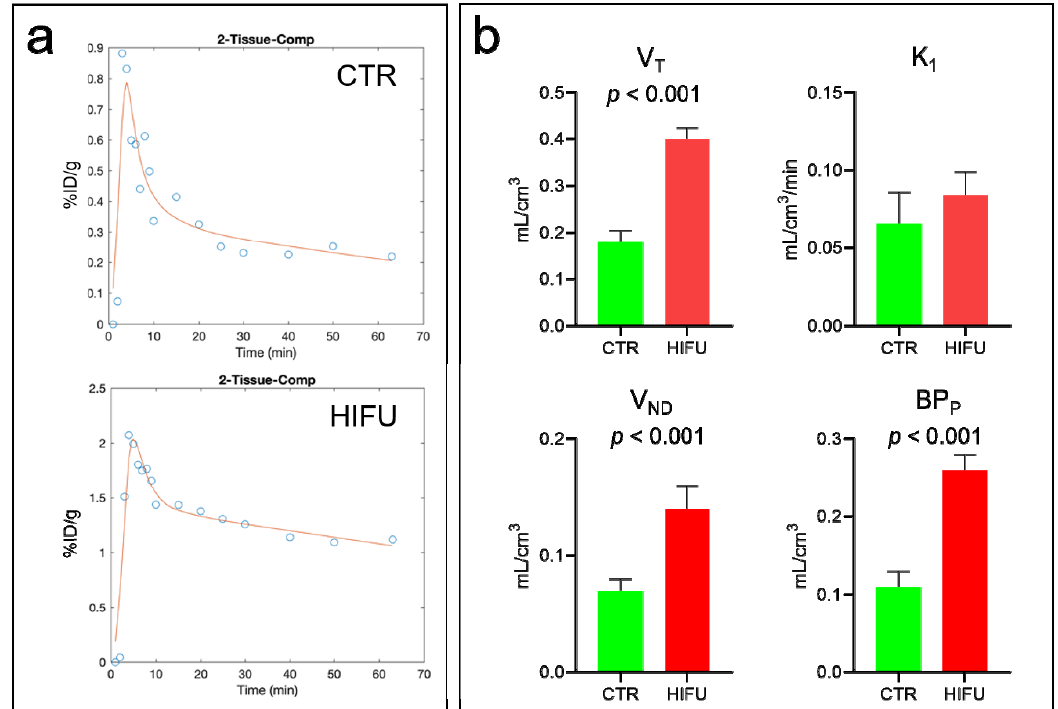
Figure 6. Kinetics of [ 11 C] topotecan in mice after HIFU with microbubbles treatments. ( a ) 2TCM modeling of [ 11 C] topotecan distribution in the control and HIFU ‐ treated mice. ( b ) [ 11 C] topotecan total distribution volume (V T ), [ 11 C] topotecan non ‐ displaceable distribution volume (V ND ), the distribution volume of specifically bound [ 11 C] topotecan (BP P ), and rate constant for [ 11 C] topotecan transfer from arterial plasma to the brain (K 1 ) in brains of control untreated and HIFU ‐ treated mice. Note a significantly increased V T , V ND, and BP P of [ 11 C] topotecan for the brains of mice treated with HIFU.